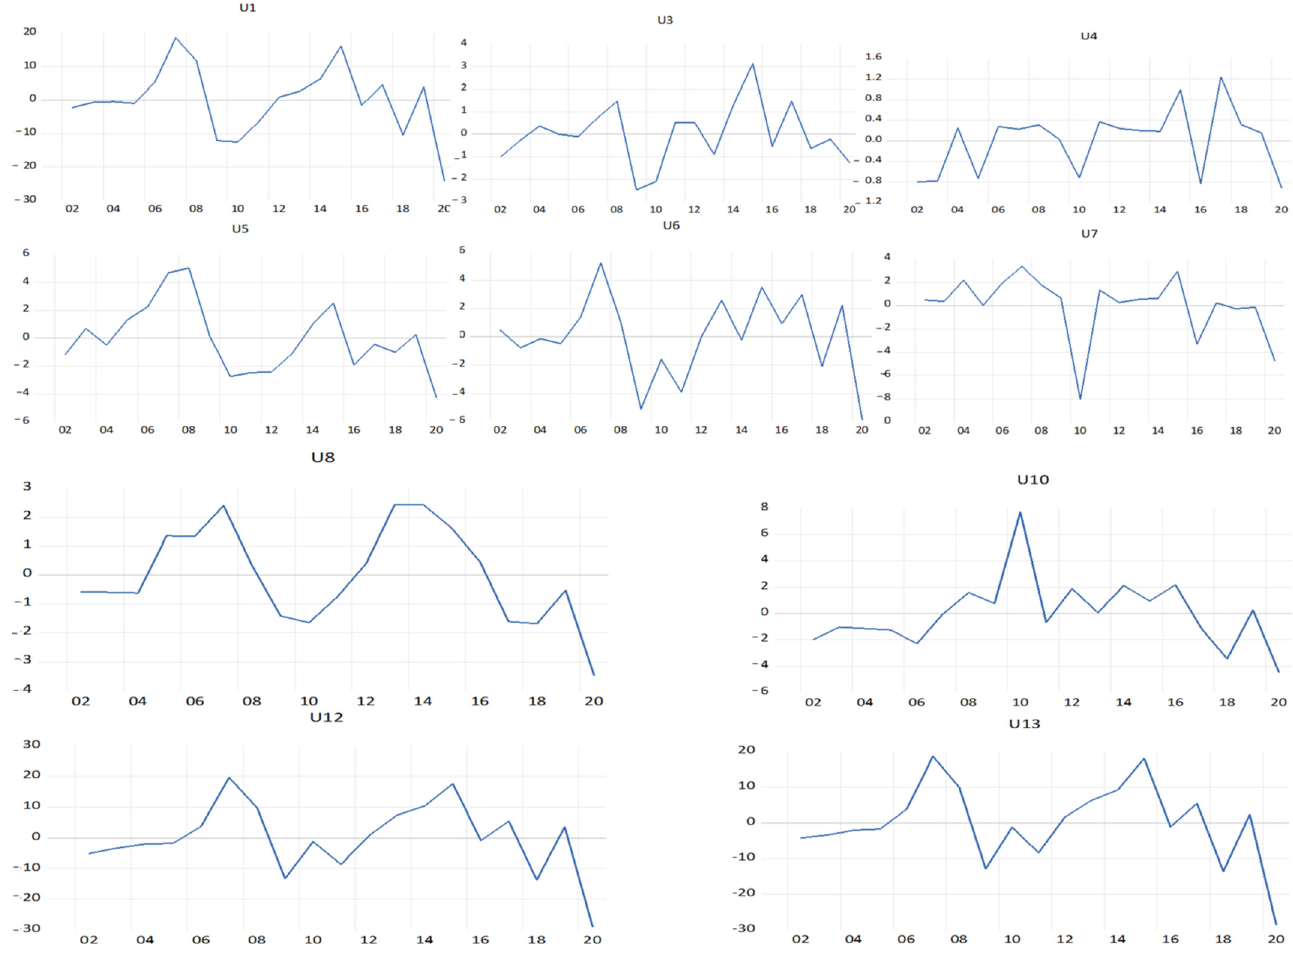
Figure 3. The residual - based ADF test for Test 1.